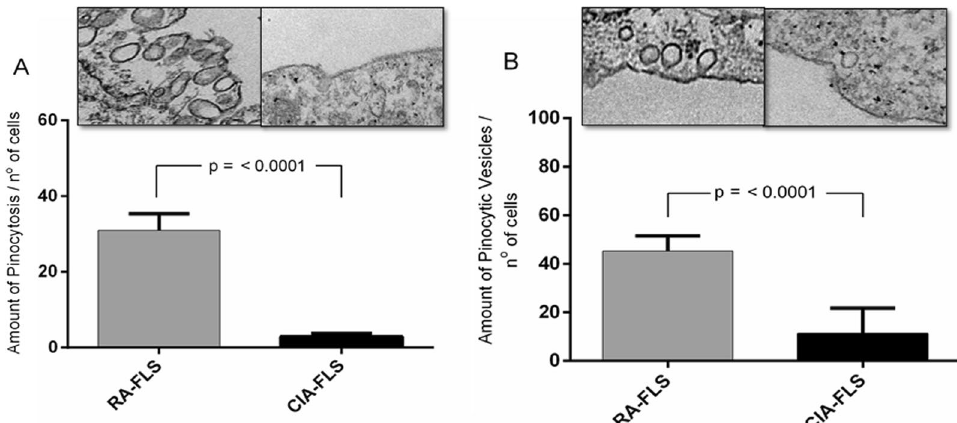
Fig. 4 Pinocytosis vesicle and pinocytosis in fibroblast-like synoviocytes from patients with rheumatoid arthritis (RA-FLS) and mice with collagen-induced arthritis (CIA-FLSs). A Higher amount of pinocytosis in RA-FLSs than in CIA-FLSs. B Higher numbers of pinocytic vesicles in RA-FLSs than in CIA-FLSs. p < 0.05 was considered statistically significant